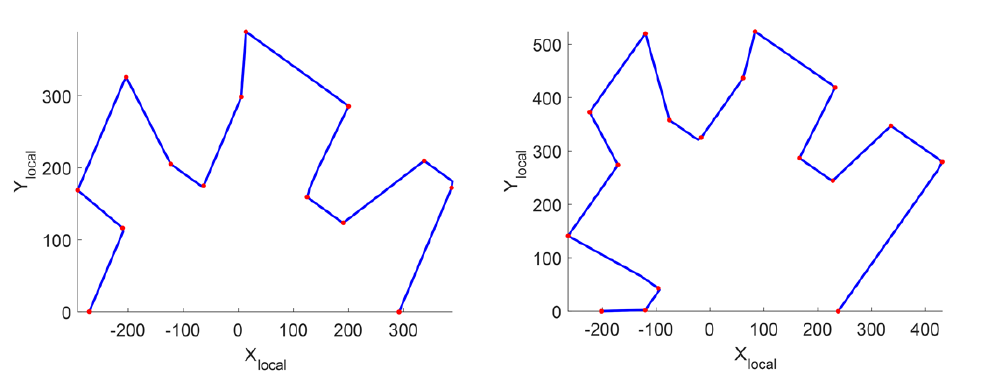
Figure 5. Correctly detected corners of ( left ) VSD and ( right ) RSD, which are marked with red